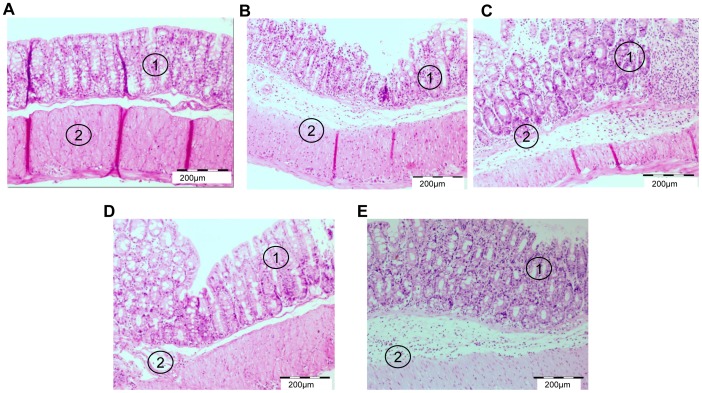
Histopathological characterization of colon segments mice with DSS-induced colitis.Magnification×10. A: Distal colon sections of control mouse showing well organized crypts with goblet cells (1) and lamina propria (2). B: Colon of PBS-injected mouse with DSS-induced colitis showing crypt loss (1), mucosal erosions, sub-mucosal edema and massive infiltration of inflammatory cells (2). C: Colon of mouse treated with rivastigmine (0.5 mg/kg) that partially repaired the crypt dysplasia (1) but had little effect on cellular infiltrate and edema of the sub-mucosal layer (2). D: Colon of mouse treated with rivastigmine (1 mg/kg) that partially restored crypt damage (1), reduced sub-mucosal edema (2) and prevented cellular inflammatory infiltrate. E: Co administration of scopolamine (1 mg/kg) and rivastigmine (1 mg/kg) increased sub-mucosal edema and cellular infiltrate compared to that in colon of mice given rivastigmine (1 mg/kg) alone.